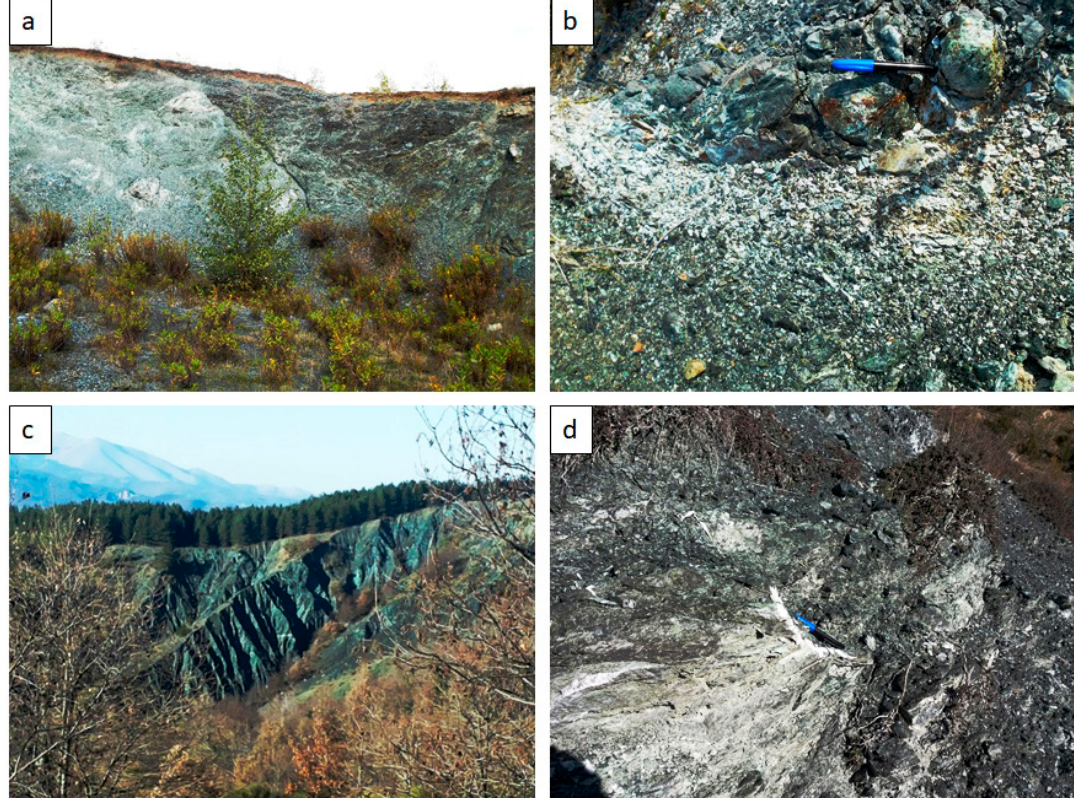
Figure 2. Serpentinite outcrops of the Pollino Massif: ( a ) Fagosa quarry, ( b ) Mt. Nandiniello, ( c ) Fosso Arcangelo site, and ( d ) San Severino Lucano site.